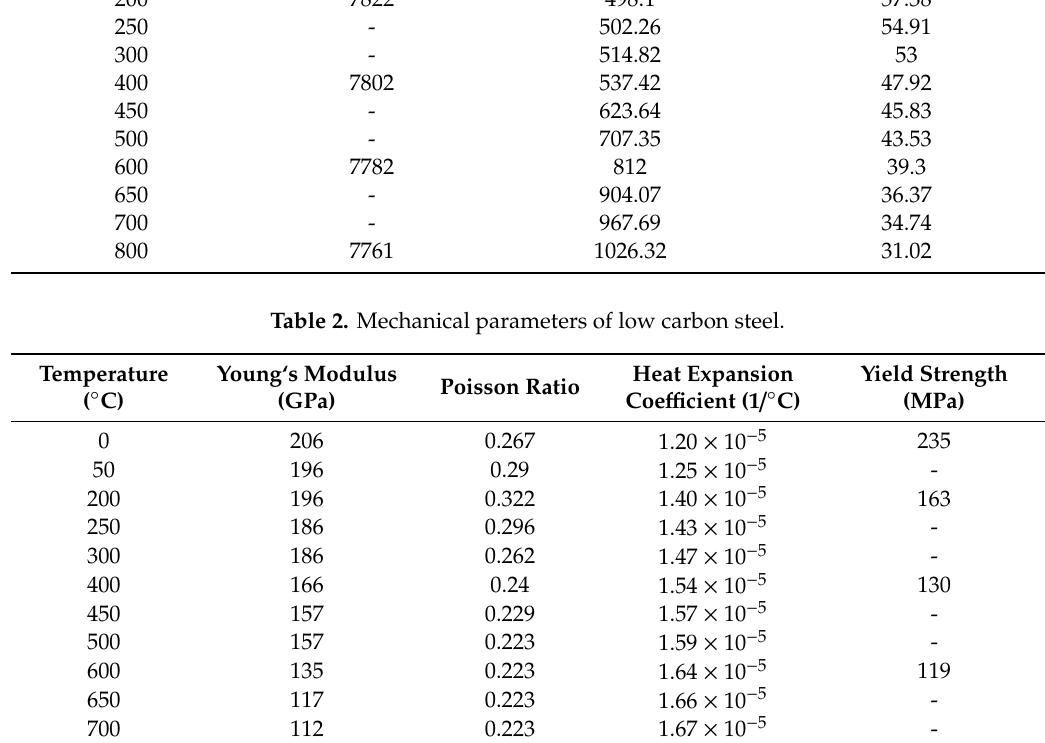
Table 1. Th ermal parameters of low carbon steel.